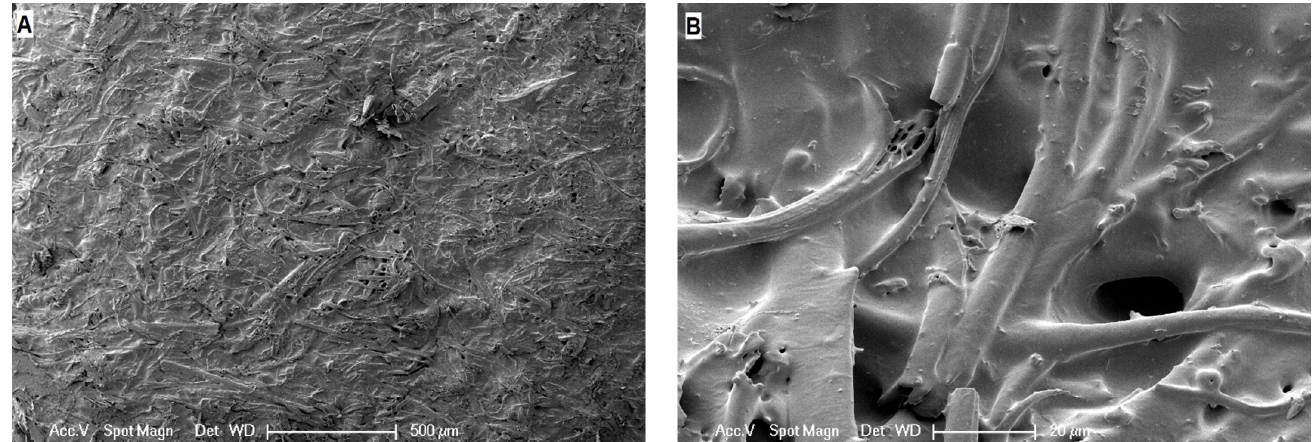
Figure 9. SEM images of vulcanized samples from EPDM mixture M2 without sulfur after extraction with toluene for 72 h. 50 × magnification of the mixture with 68 phr of 80 µ m feathers on the ( A ) and 1000 × magnification of the mixture with 100 phr of 200 µ m feathers on the ( B